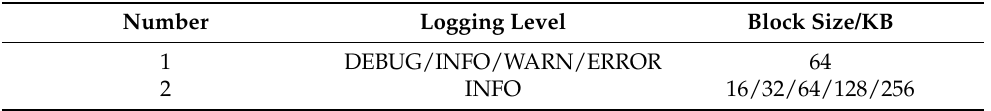
Figure 11. Latency testing of the traceability function.